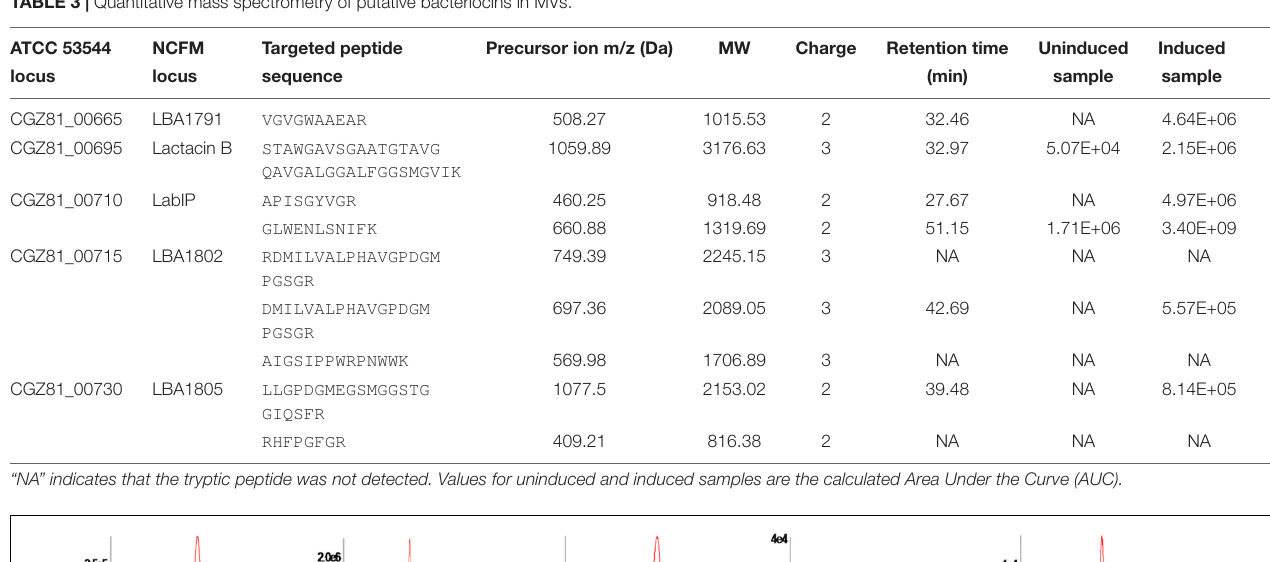
TABLE 3 | Quantitative mass spectrometry of putative bacteriocins in